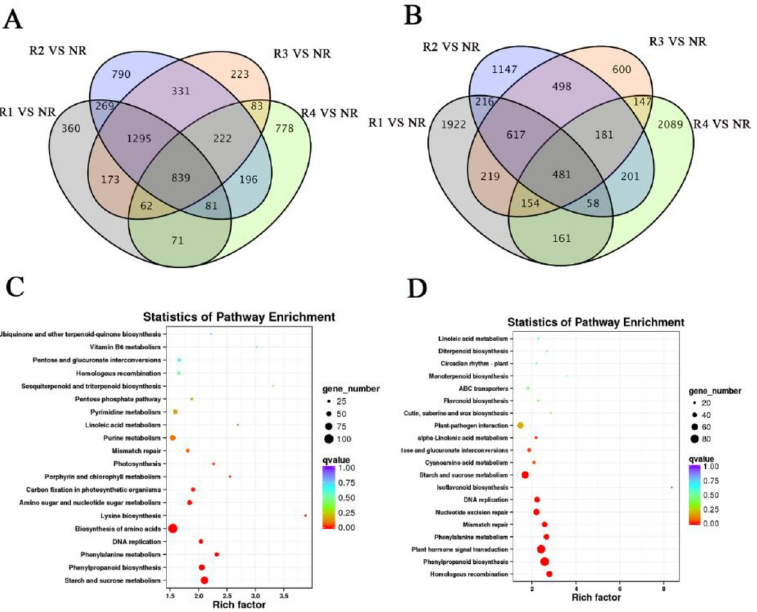
Fig 2. NR differential gene analysis. (A) Venn diagram of upregulated genes. (B) Venn diagram of downregulated genes. (C) KEGG pathway enrichment analysis of upregulated genes for NR. (D) KEGG pathway enrichment analysis of downregulated genes for